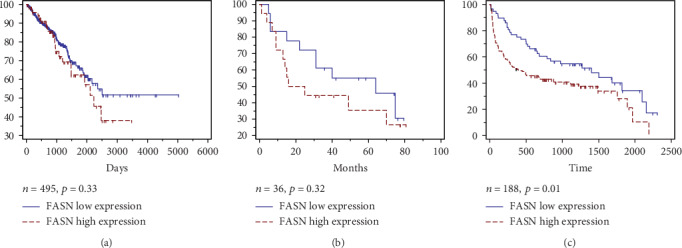
The relationship between FASN expression and patient prognosis. (a) Kaplan–Meier analysis of BCR-free survival in patients' data retrieved from TCGA (n = 495, p = 0.33), (b) Correlation between FASN expression and BCR-free survival in GEO dataset (n = 36, p = 0.32). (c) Disease-free survival in TMA patients (n = 188, p = 0.01). The log-rank test shows that PCa patients with high FASN expression have shorter disease-free survival time.